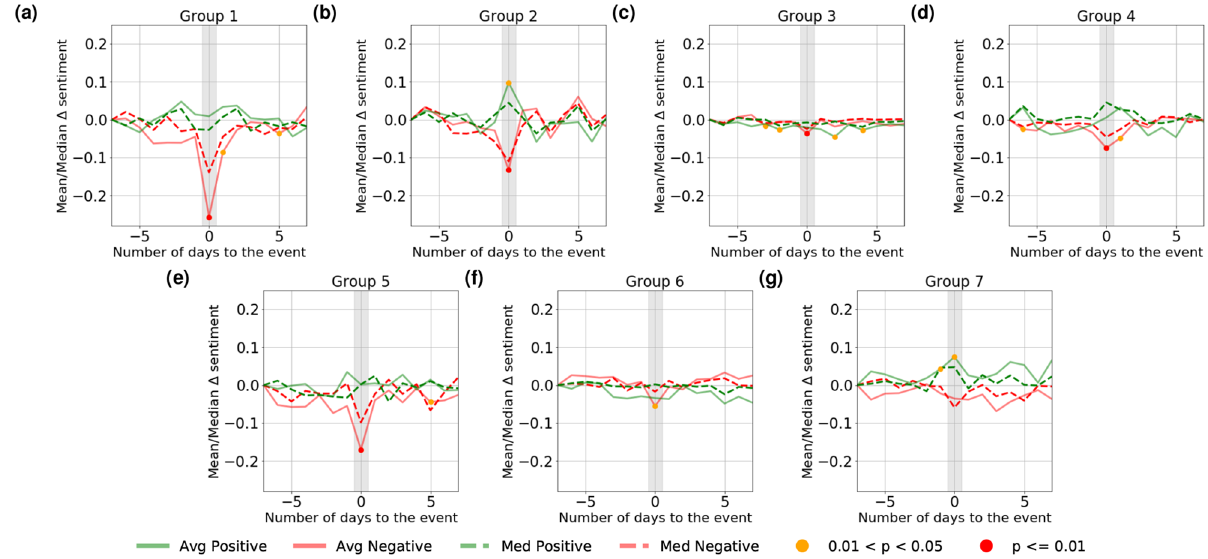
Figure 2. Change in mean and median group aggregate sentiment score of the major Figure S6 in Supplementary information, we show results for six top companies from Technology and Financial sectors (Google, Microsoft, Apple, Goldman Sachs, JP Morgan, and Lehman Brothers). It can be seen that Google and Apple had an increasing centrality in the network while Microsoft had a decreasing one in the seven years investigated. The three financial companies had decreasing centrality and Lehman Brothers faded quickly after